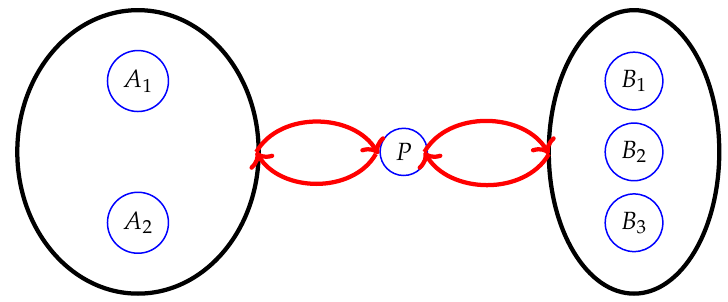
Figure 8. Resolvable network modeling communication through proxy P